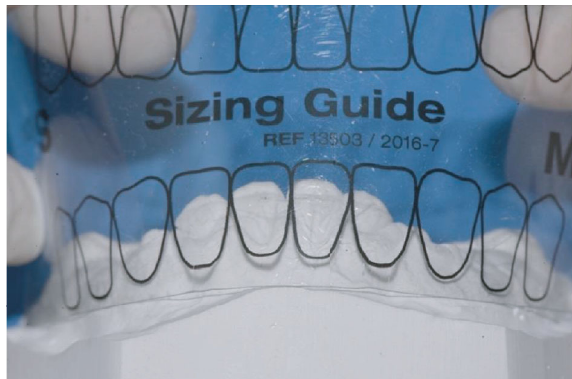
Figure 4: Edelweiss Veneer size selection using the Edelweiss sizing